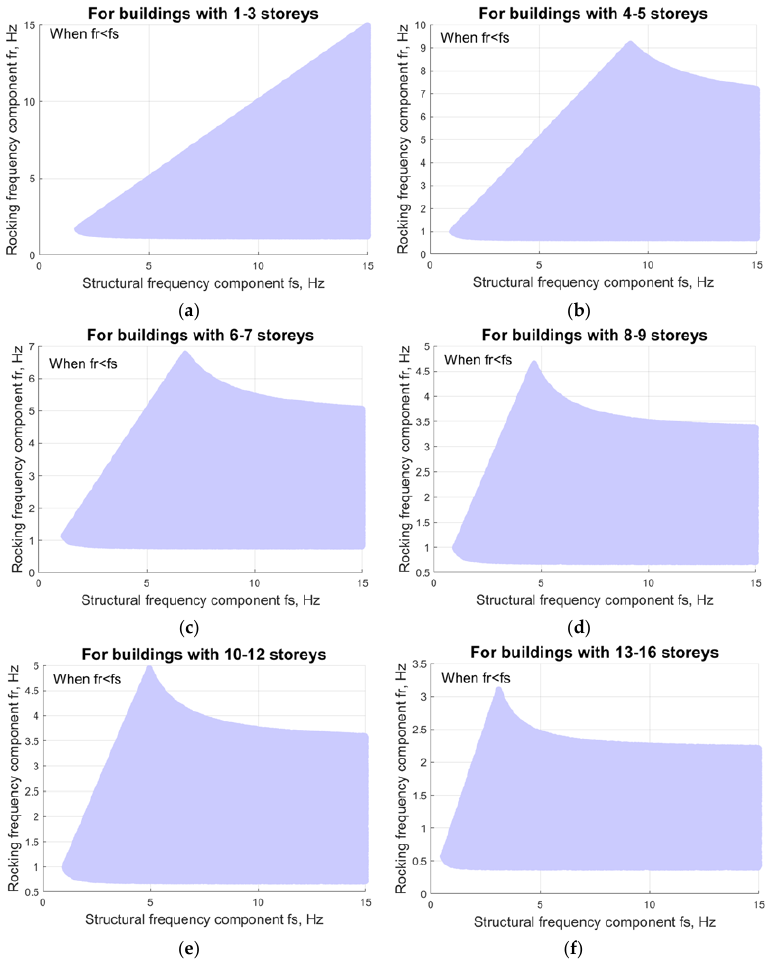
Figure 3. Modal component ranges of the first vibration mode for buildings: ( a ) 1–3 stories; ( b ) 4–5 stories; ( c ) 6–7 stories; ( d ) 8–9 stories; ( e ) 10–12 stories; ( f ) 13–16 stories. Table 6. Structural frequencies and their modal components for building reference models.